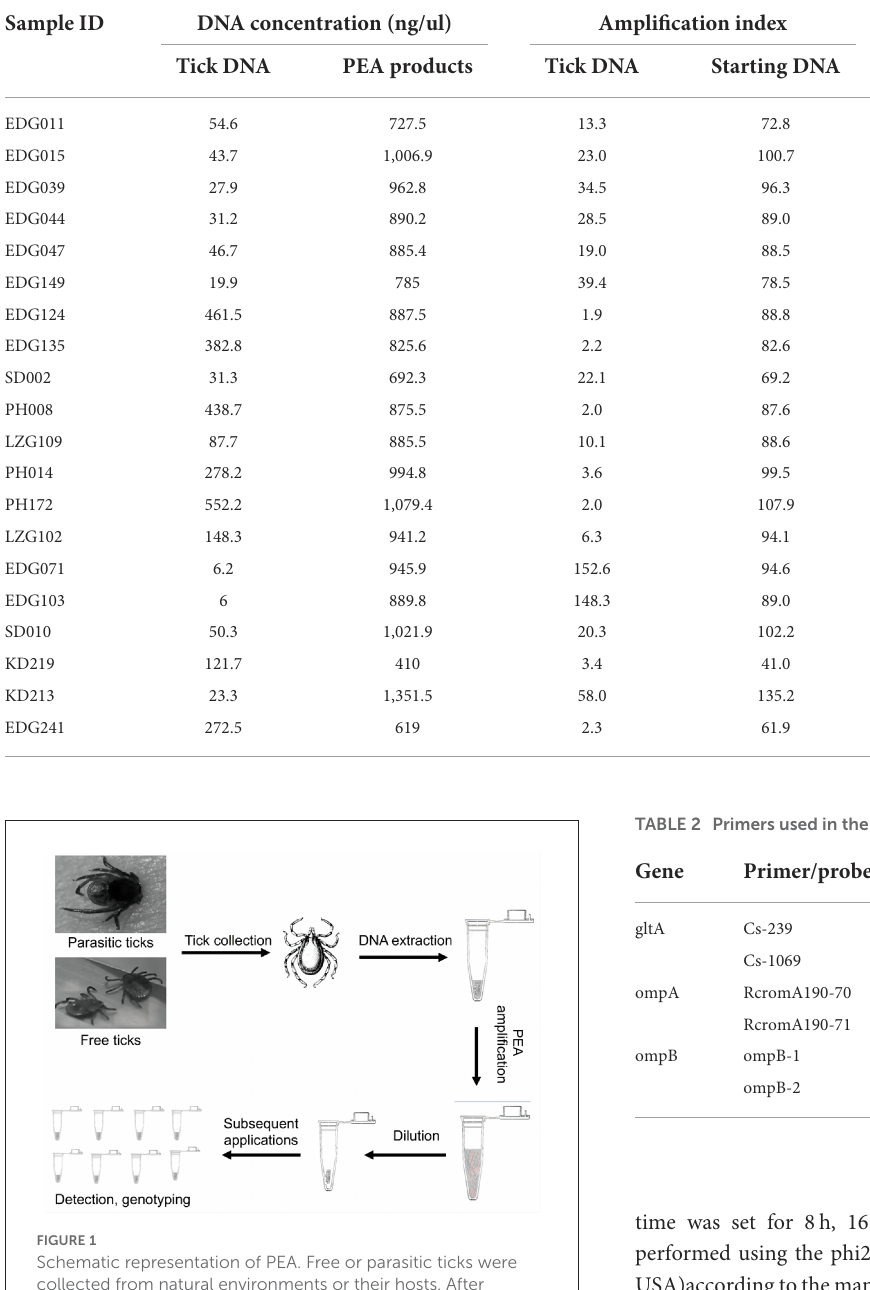
FIGURE1 Schematic representation of PEA. Free or parasitic ticks were collected from natural environments or their hosts. After washing with 70% alcohol, the ticks as subjected to DNA extraction with genomic kits and amplified with PEA. The amplified DNA could be used for PCR detection, genotyping, or genomic analysis.